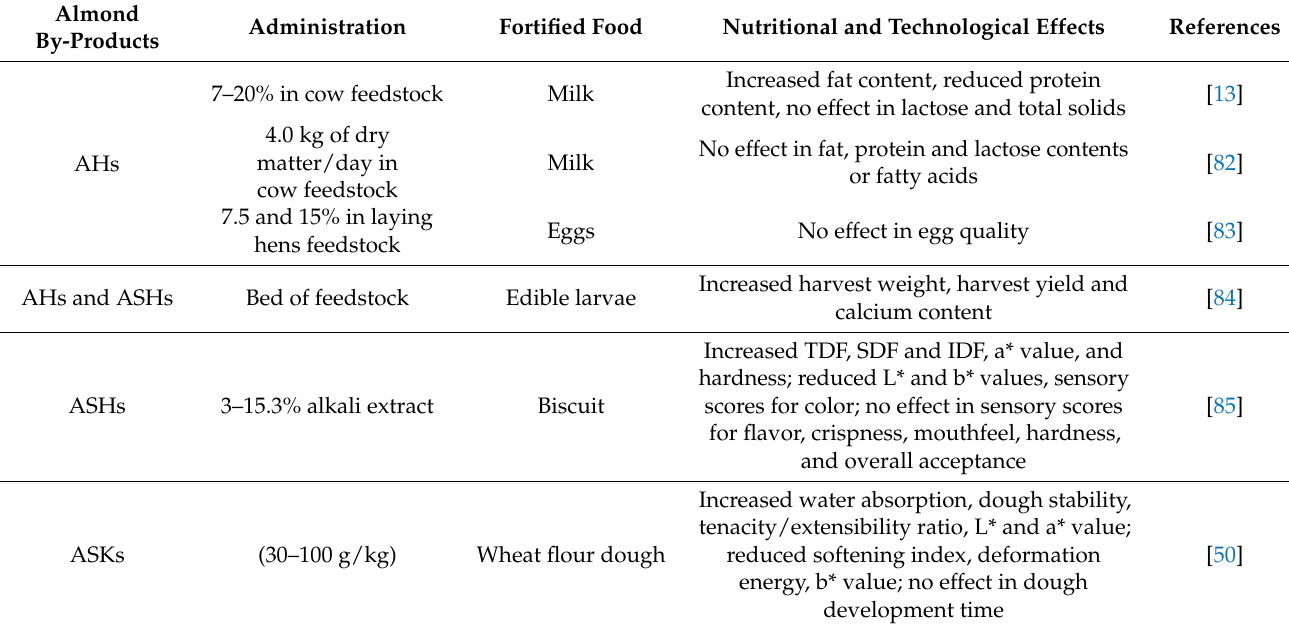
Table 2. Fortification of food products with almond